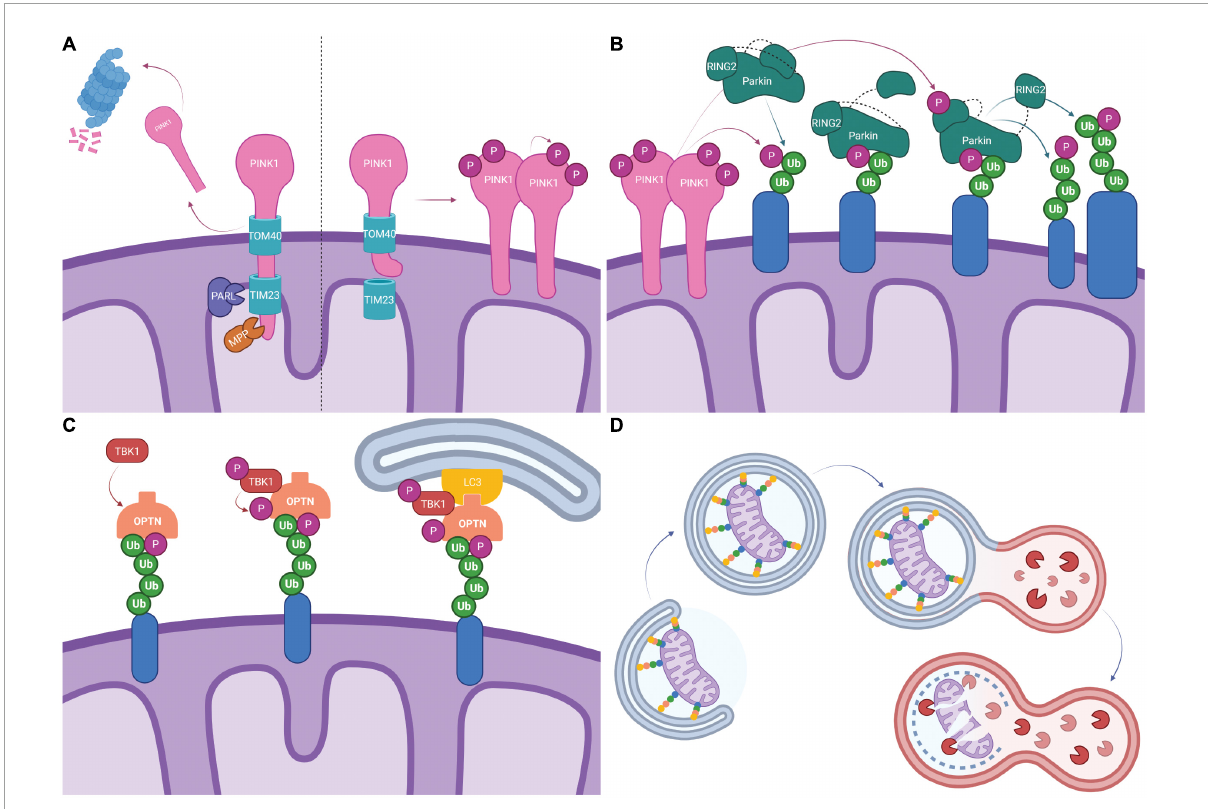
FIGURE1 Schematic representation of PINK1/Parkin dependent mitophagy. (A) Typically, PINK1 is imported into the mitochondria by TOM40/TIM23 where it is cleaved by mitochondrial proteases PARL and MPP. The c-terminal PINK1 fragment dissociates and is degraded by the proteasome (Left). Following mitochondrial depolarization, PINK1 import via TIM23 is blocked by electrostatic repulsion. PINK1 disassociates from TOM40, forms dimers and is activated by auto-phosphorylation (Right). (B) Activated PINK1 phosphorylates ubiquitinated mitochondrial proteins ( shown in blue ). Parkin binds phosphorylated ubiquitin which causes a conformational change and exposes the UBL allowing it to be phosphorylated by PINK1. This leads to additional conformational changes and exposes the catalytic site on RING2, fully activating Parkin. Parkin then ubiquitinates mitochondrial proteins, creating more substrates for PINK1 phosphorylation and feed-forward signal amplification. (C) Mitophagy receptors, here represented by OPTN, bind ubiquitinated mitochondrial proteins (shown in blue) . TBK1 mediated phosphorylation of mitophagy receptors enhances ubiquitin binding. LIR domains on mitophagy receptors recruit the phagophore via LC3 binding. (D) Elongation of the phagophore leads to the engulfment of mitochondria into mitophagosomes. Mitophagosomes fuse with lysosomes and lysosomal proteases degrade the mitochondria. Created with